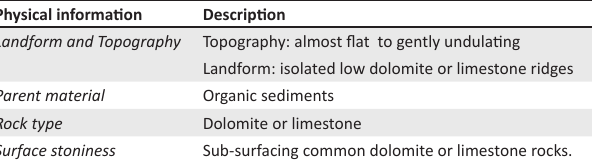
TABLE A1.1a: Differentiating characteristics of the lithic Leptosols.